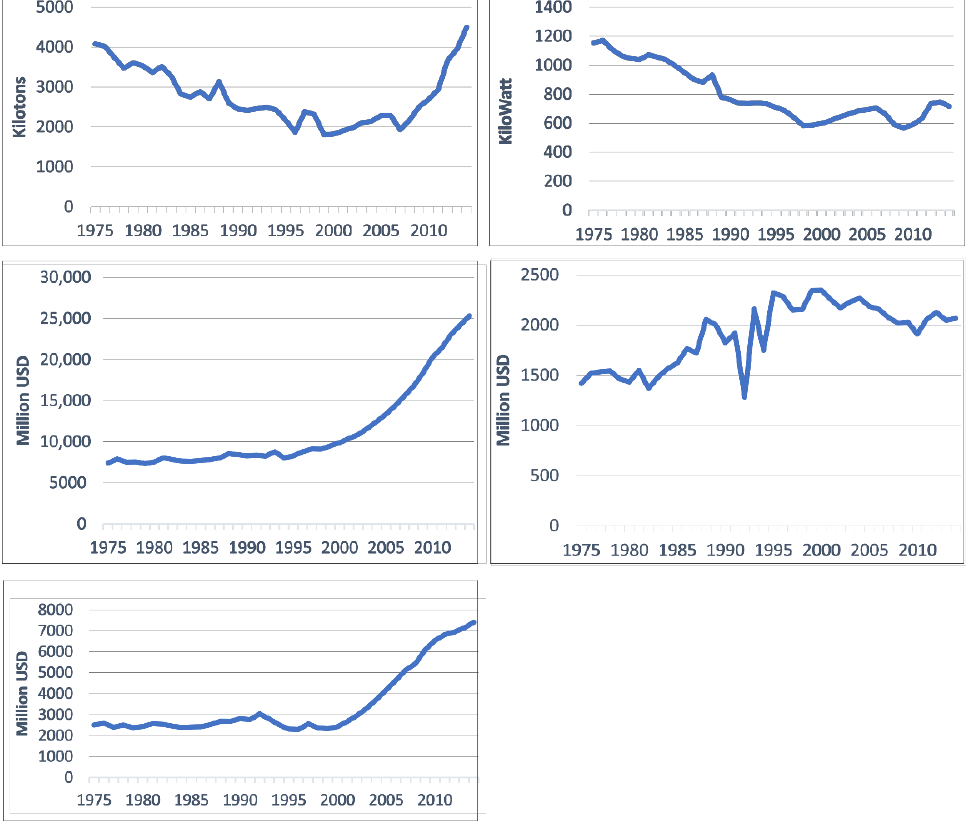
Table A1. ARDL estimation output (results).